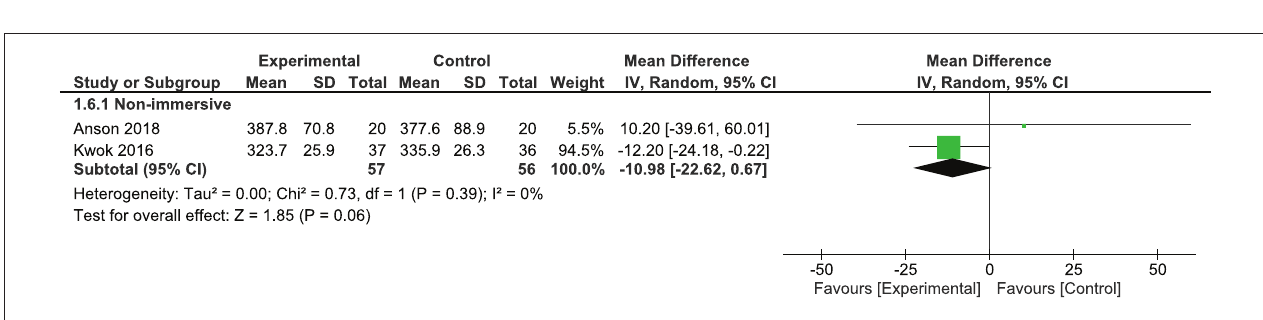
FIGURE 3 | Forest plot of outcome measures for balance assessment using Berg Balance Scale (BBS) for VR-based therapy vs. control (EoT).